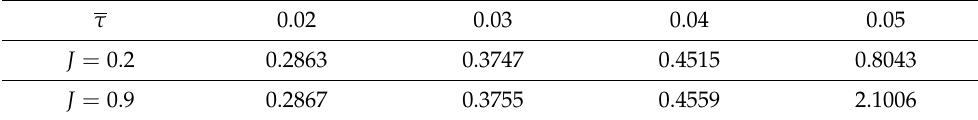
Table 6. Minimum γ for various of τ and J values in Case 3.